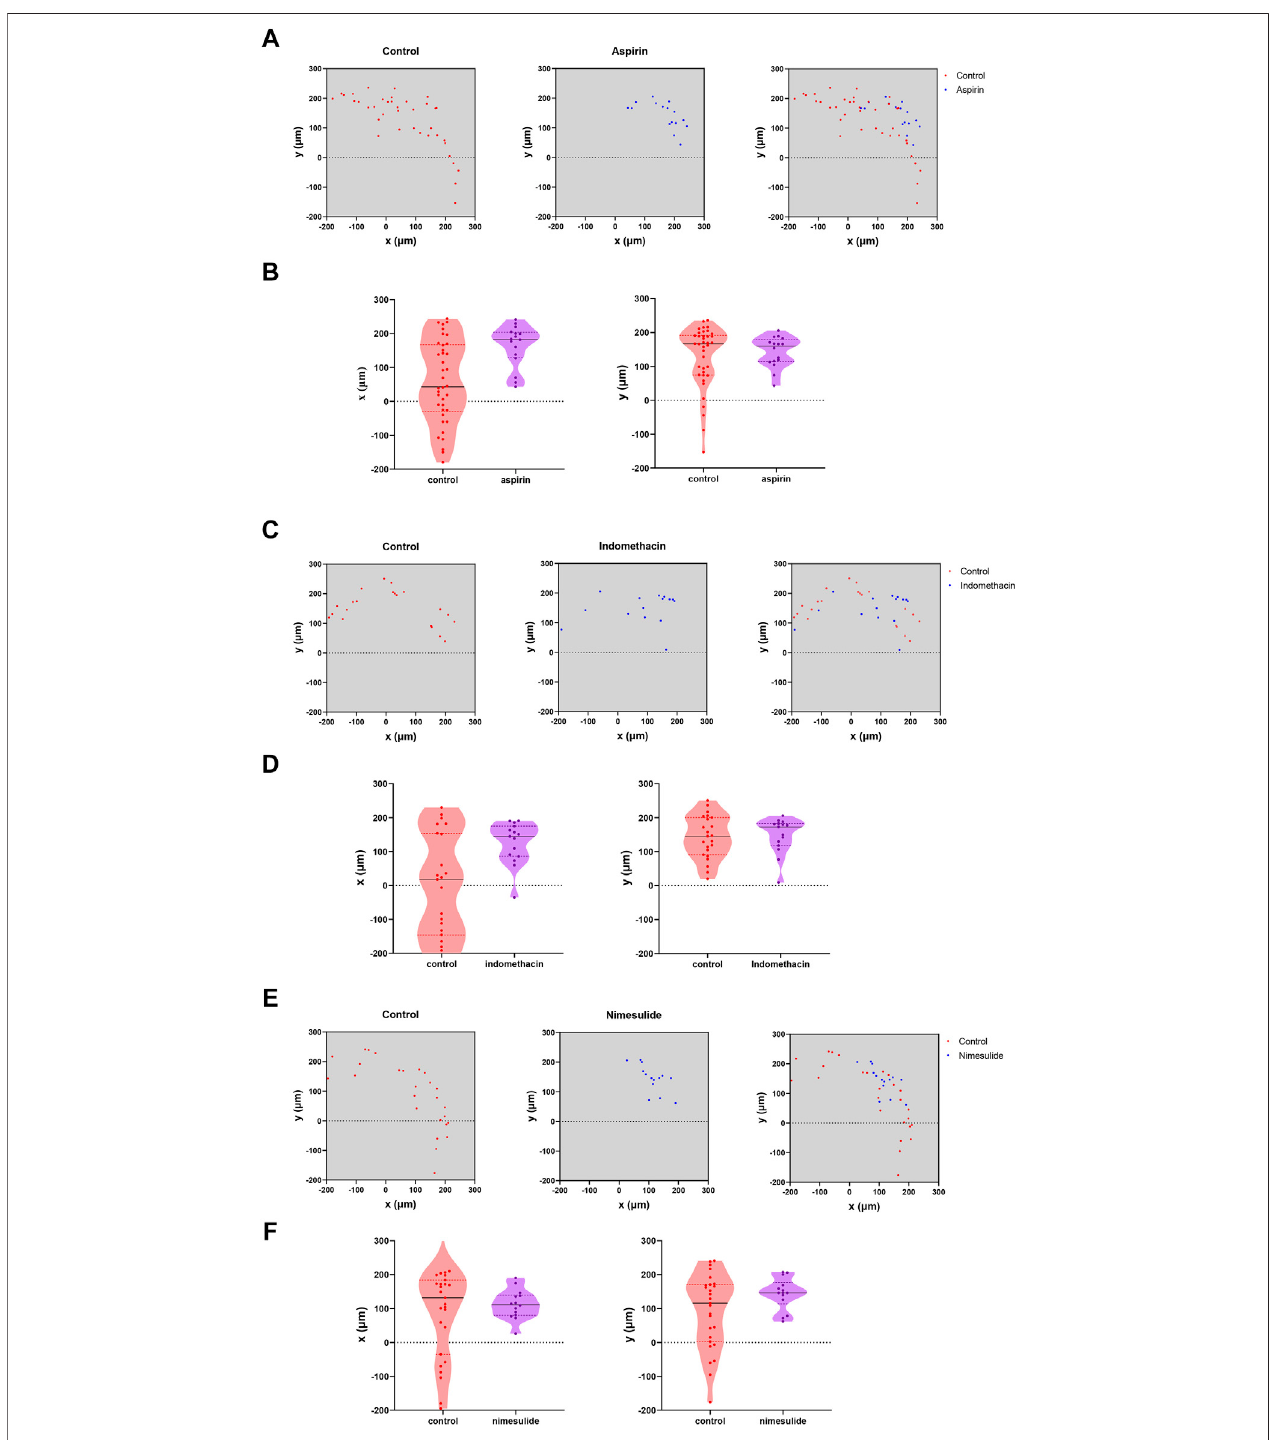
FIGURE10 | AnalysisofNSAIDs ’ Anti-Cal27 cells Migration in Microtubes Model (A) Quanti fi cation ofthelocation of fl uorescently labeled cellsin microtubesin the aspirinandcontrolgroups (B) Analysisofthemigrationtrendsofcellsinthe x -axisand y -axisdirectionsonmicrotubesintheaspirin-andcontrolgroups,respectively (C, D) Indomethacin group analysis (E,F) Nimesulide group analysis.